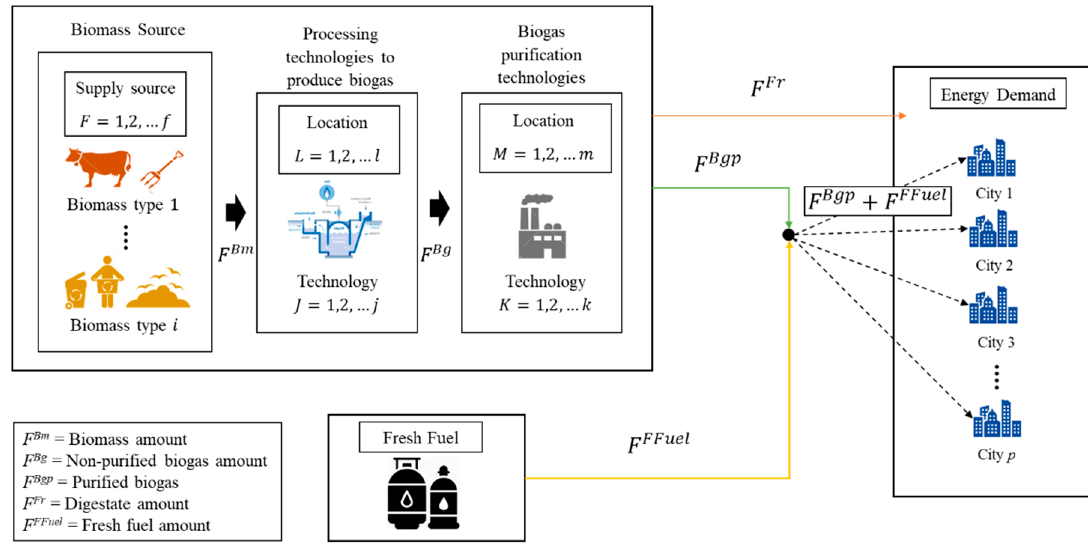
Figure 3. Superstructure for the proposed system.